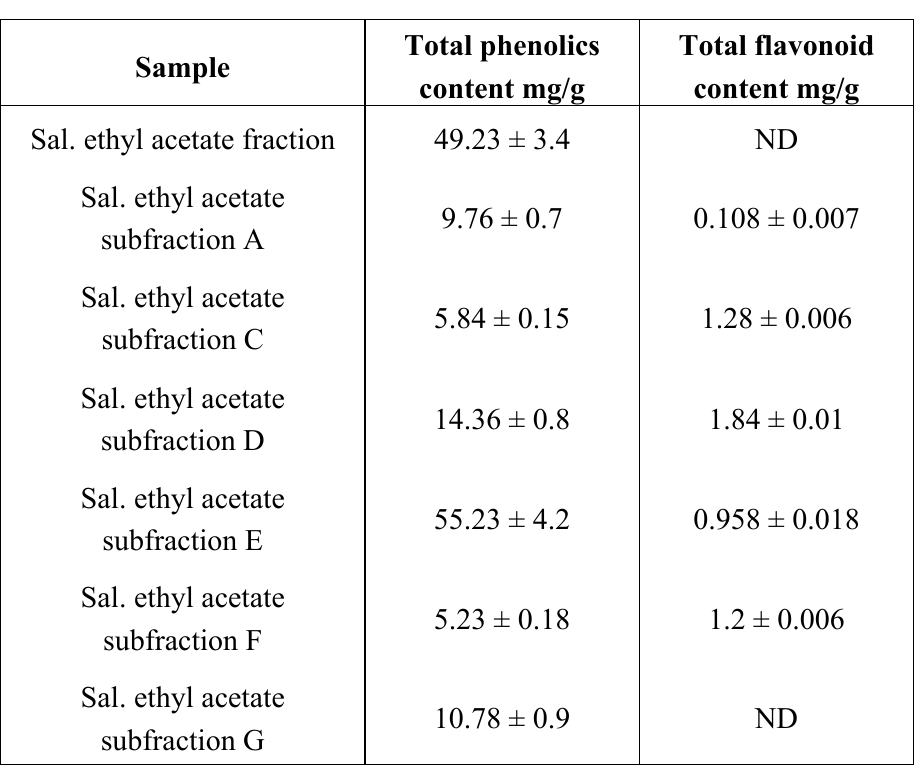
Table 3. The amount of total phenolics and flavonoids in Salvia mirzayanii subfractions.